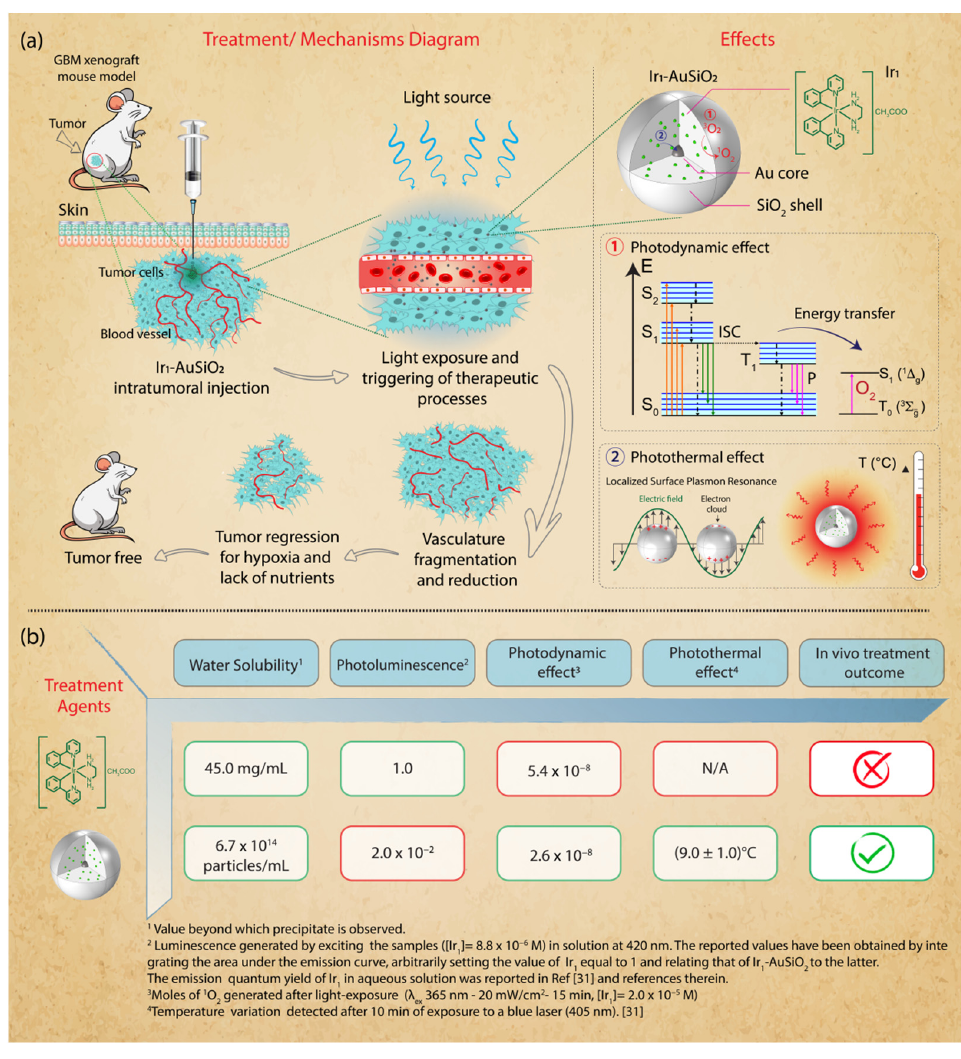
Figure 1. Overview of the therapeutic approach for human GBM treatment in xenograft mouse model. ( a ) Intratumoral injection of Ir 1 -AuSiO 2 , distribution and accumulation next to blood vessel